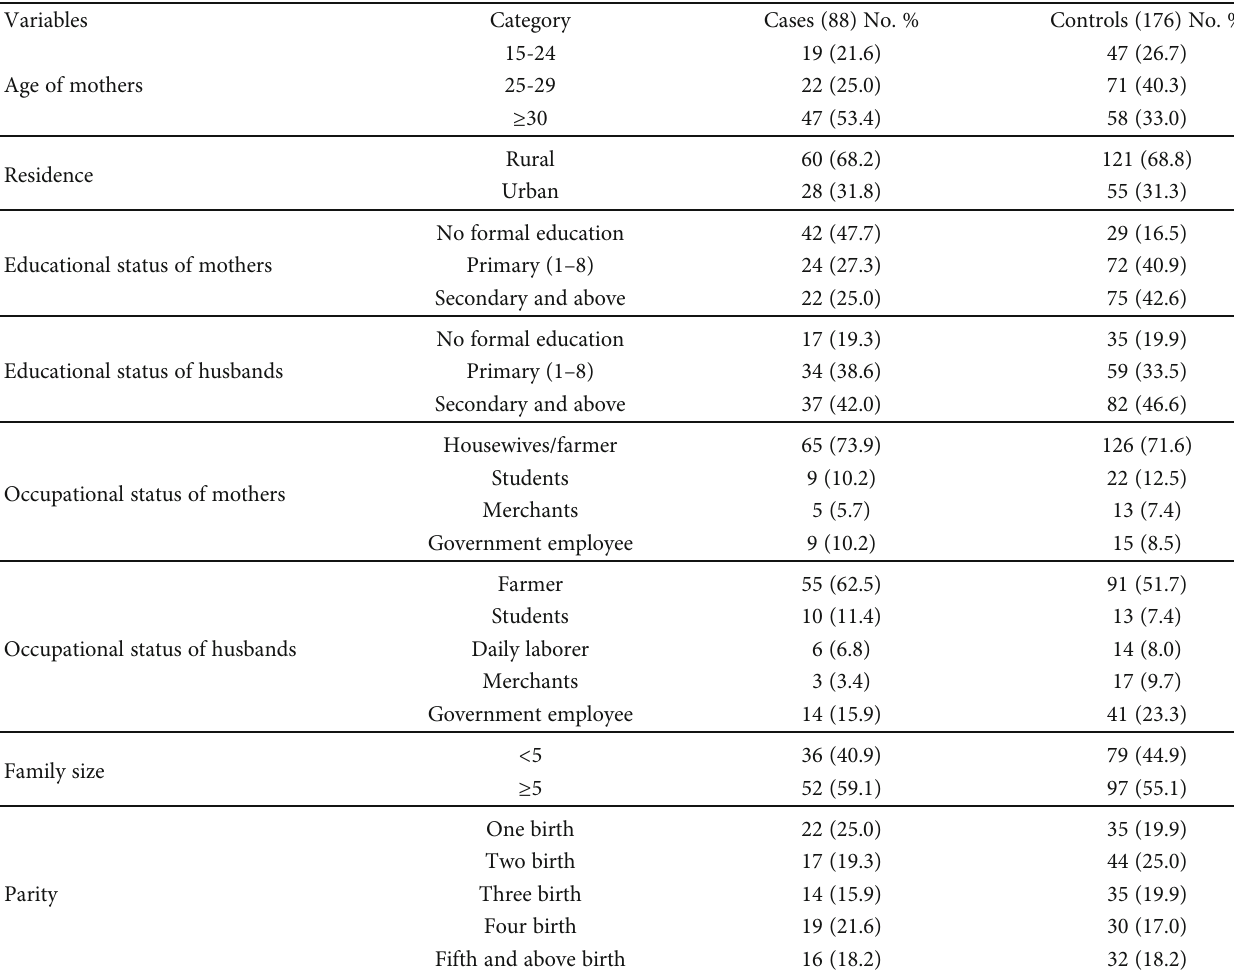
Table 1: Sociodemographic characteristics of cases and controls in Abobo District, Gambella region, Southwest Ethiopia,